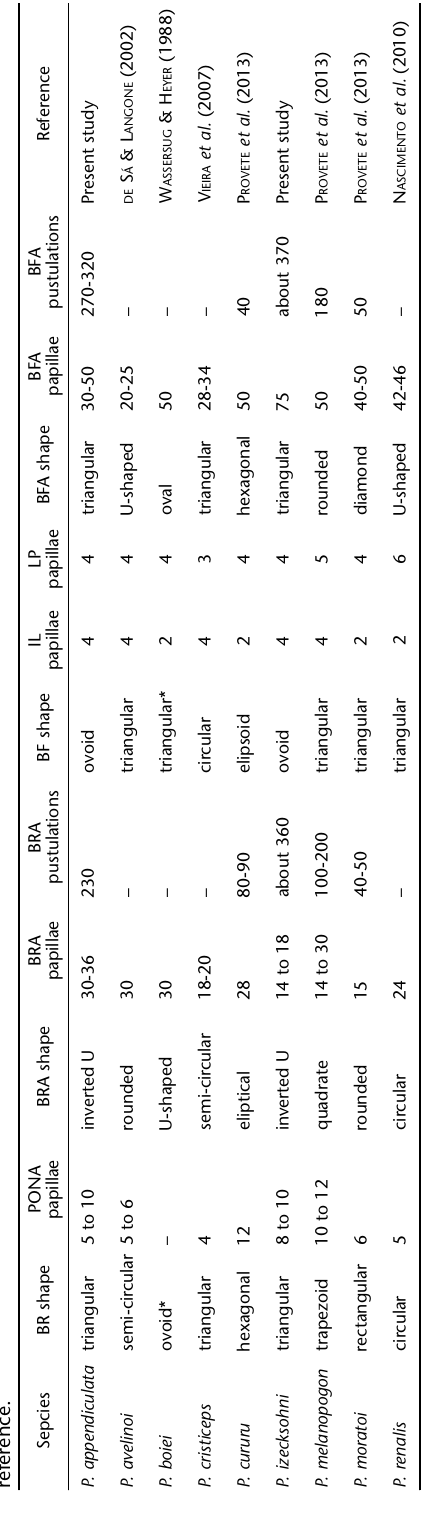
dots absent) and a single cream dot on the dorsum (absent).